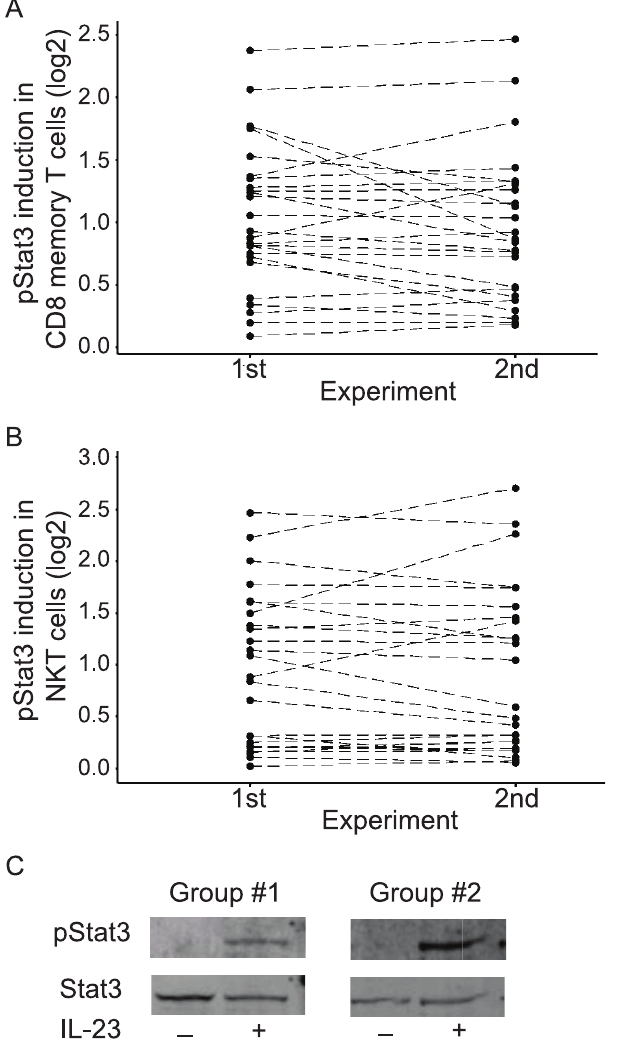
Figure 2. Reproducibility of IL-23 responsiveness as assessed by pSTAT3 induction. Peripheral whole blood was stimulated with 100 ng/ml IL-23 for 15 minutes and pSTAT3 induction was assessed by phospho-flow assay. Repeated measures of IL-23-mediated pSTAT3 induction were performed for 25 randomly selected individuals, with the first and the second experiments separated by at least a three-week interval. IL-23 responsiveness was calculated as the log2 ratio of geometric mean fluorescence intensity (GMFI) of pSTAT3 in stimulated vs. unstimulated samples for (A) CD8 + CD45RO + memory T cells, and (B) CD3 + CD56 + NKT cells. (C) IL-23-mediated pSTAT3 induction assessed by Western blot analysis in FACS sorted CD8 + CD45RO + memory T cells from individuals showing low (Group # 1) or high (Group # 2) IL-23- mediated pSTAT3 induction in phospho-flow assays.